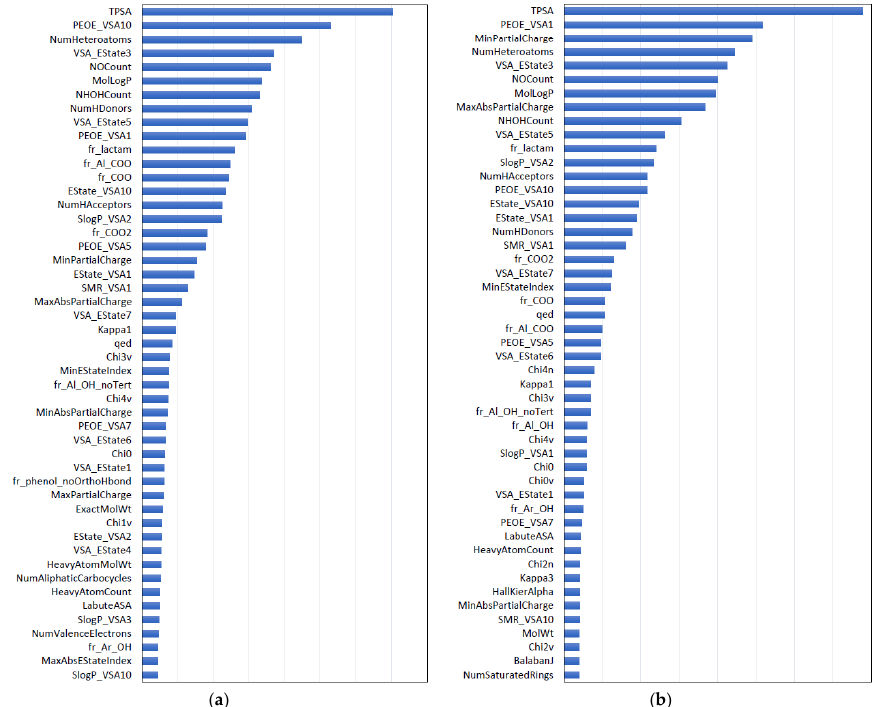
Figure 3. Importance of the top 50 molecular descriptors obtained by the RF method for the free-form dataset ( a ) and the in-blood-form dataset ( b ). Table 1. Nine descriptors with clear chemical meaning obtained by the random forest method.